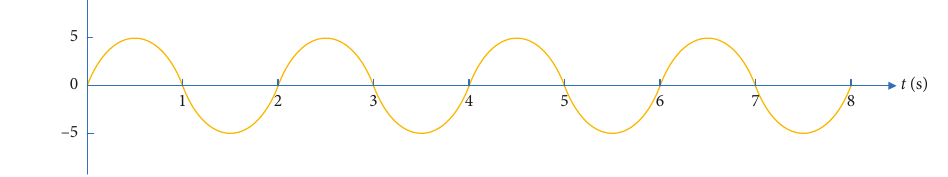
Figure 15: Sine-wave load at point A .